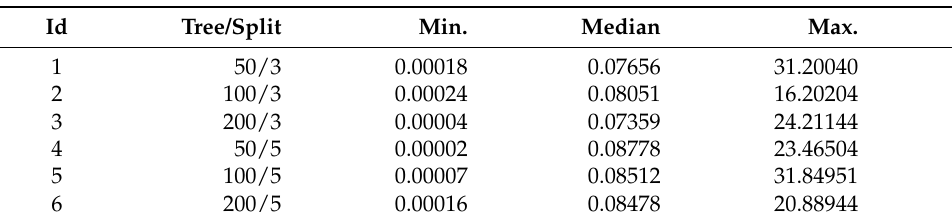
Table 9. Error statistics of the P critical estimate using a Random Forest with a distinct number of trees and splits.